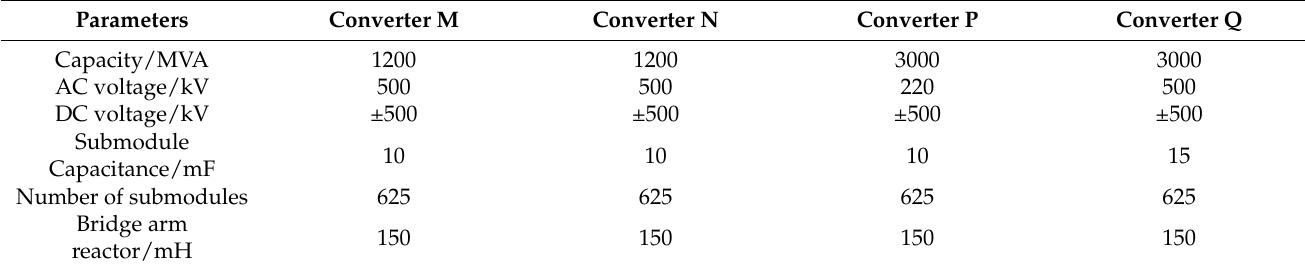
Table 1. Main Parameter Of MMC-HVDC.